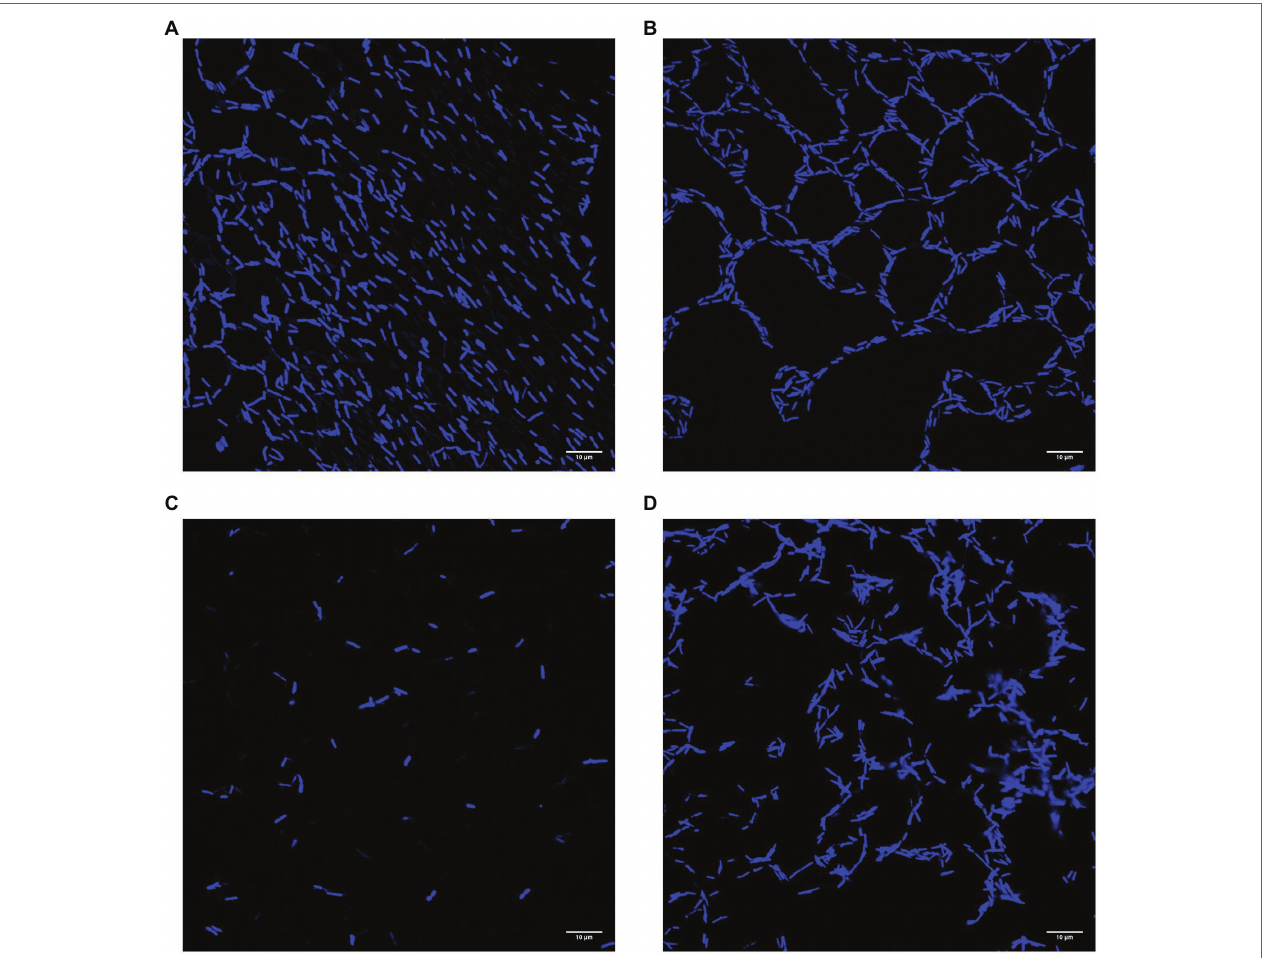
FIGURE 6 | Confocal images of biofilms of wild type and deletions of gldN and sprB on polystyrene slides. Cells of biofilms grown in wells on polystyrene cell slides in 1/40 CYE overnight at 25 ° C in humid chamber were visualized by DAPI for confocal microscopy. (A) Wild type UW101 in a diffuse pattern. (B) Wild type UW101 in a “honeycomb” pattern. (C) gldN deletion CJ1631-A. (D) sprB deletion